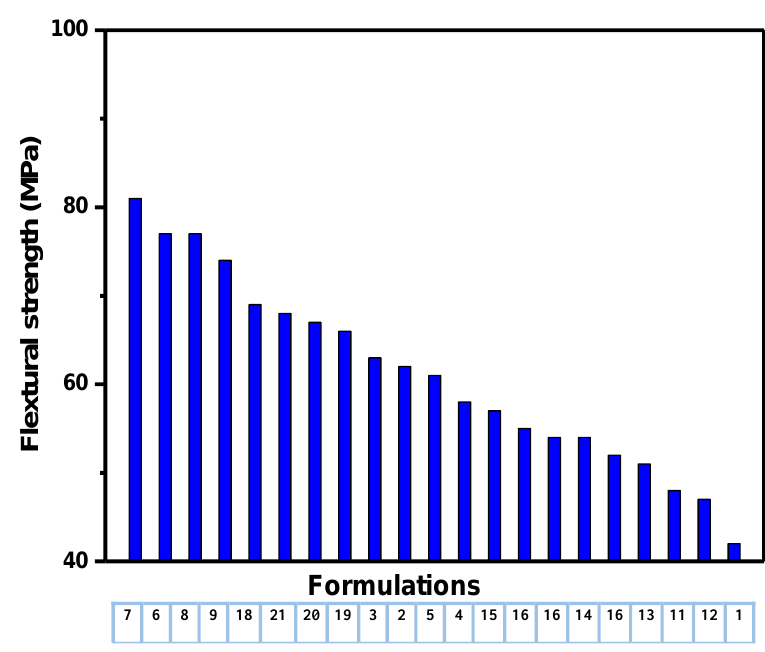
Figure 9. Flexural strength versus formulations in descending.